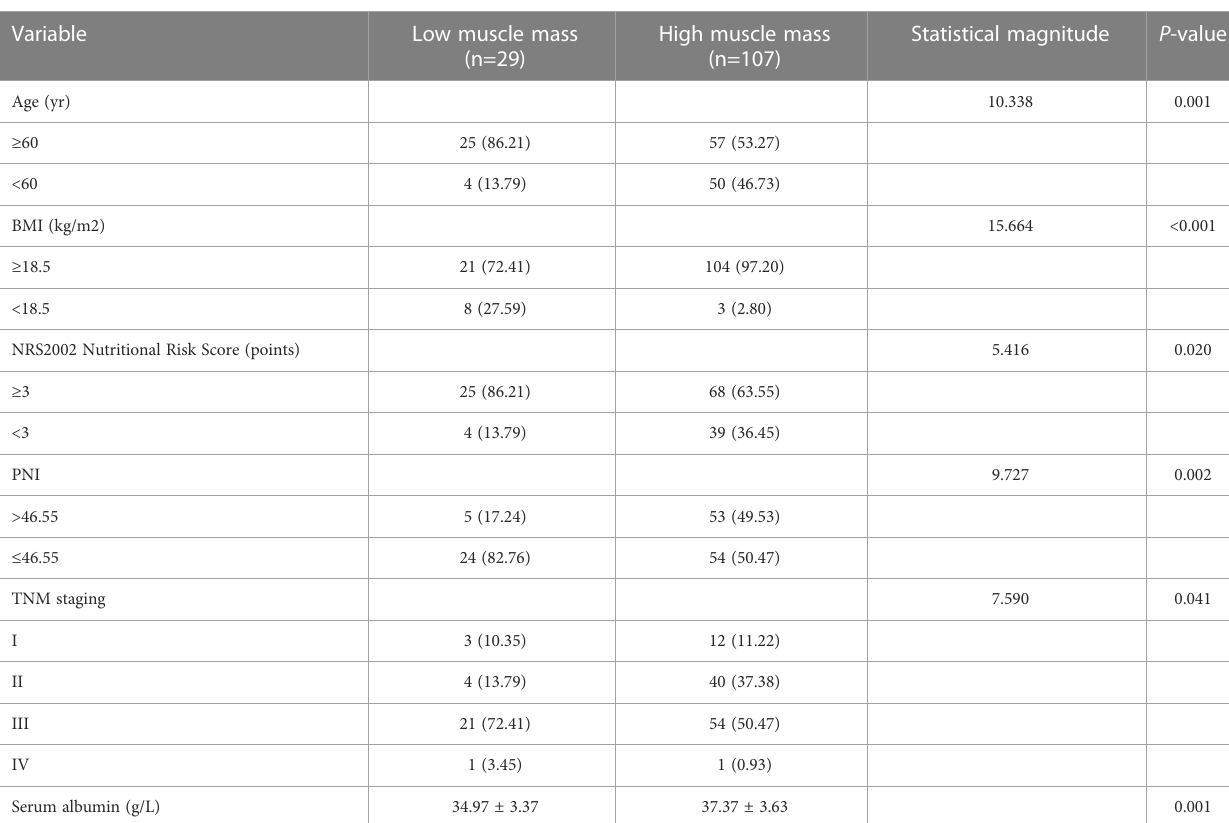
TABLE 1 Predictors of low muscle mass